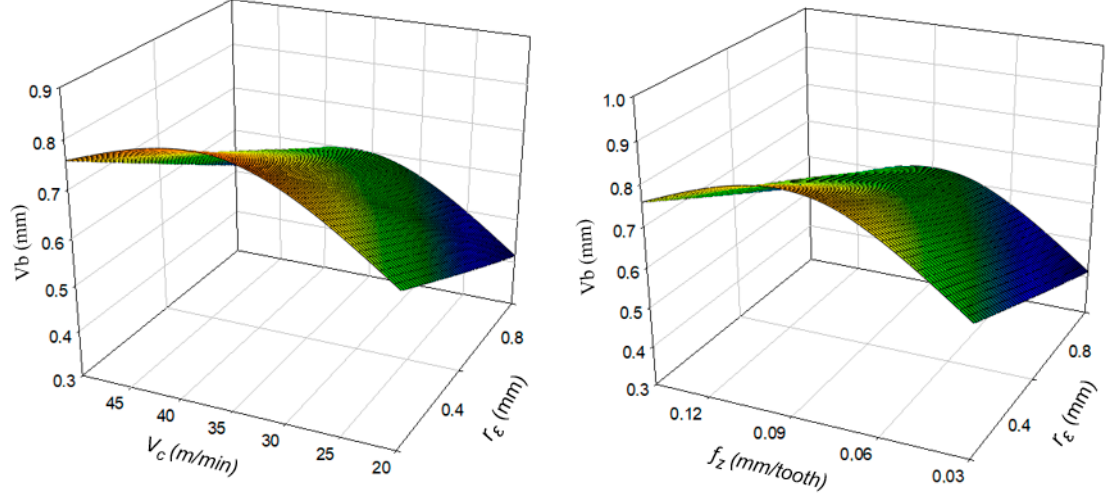
Figure 10. E ff ect of the cutting parameters on Vb. Figure 10. Effect of the cutting parameters on Vb.